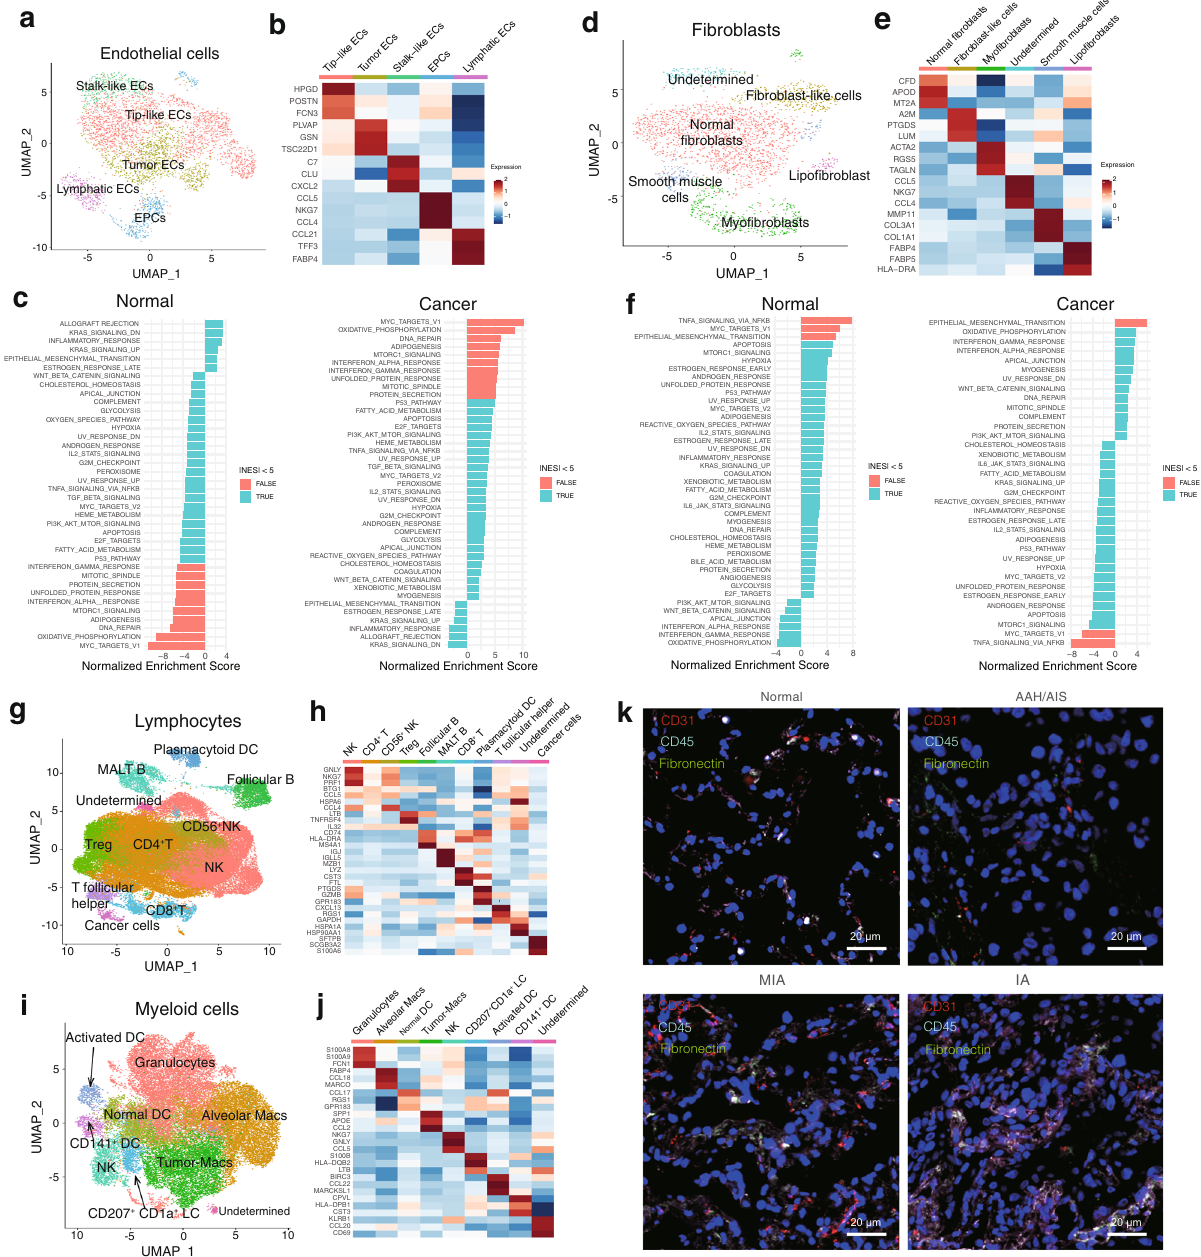
Fig. 4 Pro fi ling stromal and immune cell populations in LUAD progression. a UMAP visualization of endothelial cell clusters, color-coded by identi fi ed cell subtypes. ECs: endothelial cells; EPCs: endothelial progenitor cells. b Heatmap of selected marker genes in EC cluster subtypes. c Top enriched pathway of ECs isolated from normal or tumor tissues as determined by GSEA. d UMAP visualization of fi broblast clusters, color-coded by identi fi ed cell subtypes. e Heatmap of selected marker genes in the fi broblast cluster subtypes. f Top enriched pathway of fi broblasts isolated from normal or tumor tissues as determined by GSEA. g UMAP visualization of lymphocyte clusters, color-coded by identi fi ed cell subtypes. h Heatmap of selected marker genes in the lymphocyte cluster subtypes. i UMAP visualization of myeloid cell clusters, color-coded by identi fi ed cell subtypes. j Heatmap of selected marker genes in the myeloid cell cluster subtypes. k Co-immuno fl uorescence staining for ECs (CD31, red), immune cells (CD45, gray) and fi broblasts ( fi bronectin, green) in normal and tumor tissues from different stages. Nuclei were stained blue (DAPI). Each staining in panels come from three samples. Scale bars: 20 μ m. GSEA: Gene Set Enrichment Analysis; UMAP: Uniform Manifold Approximation and Projection.